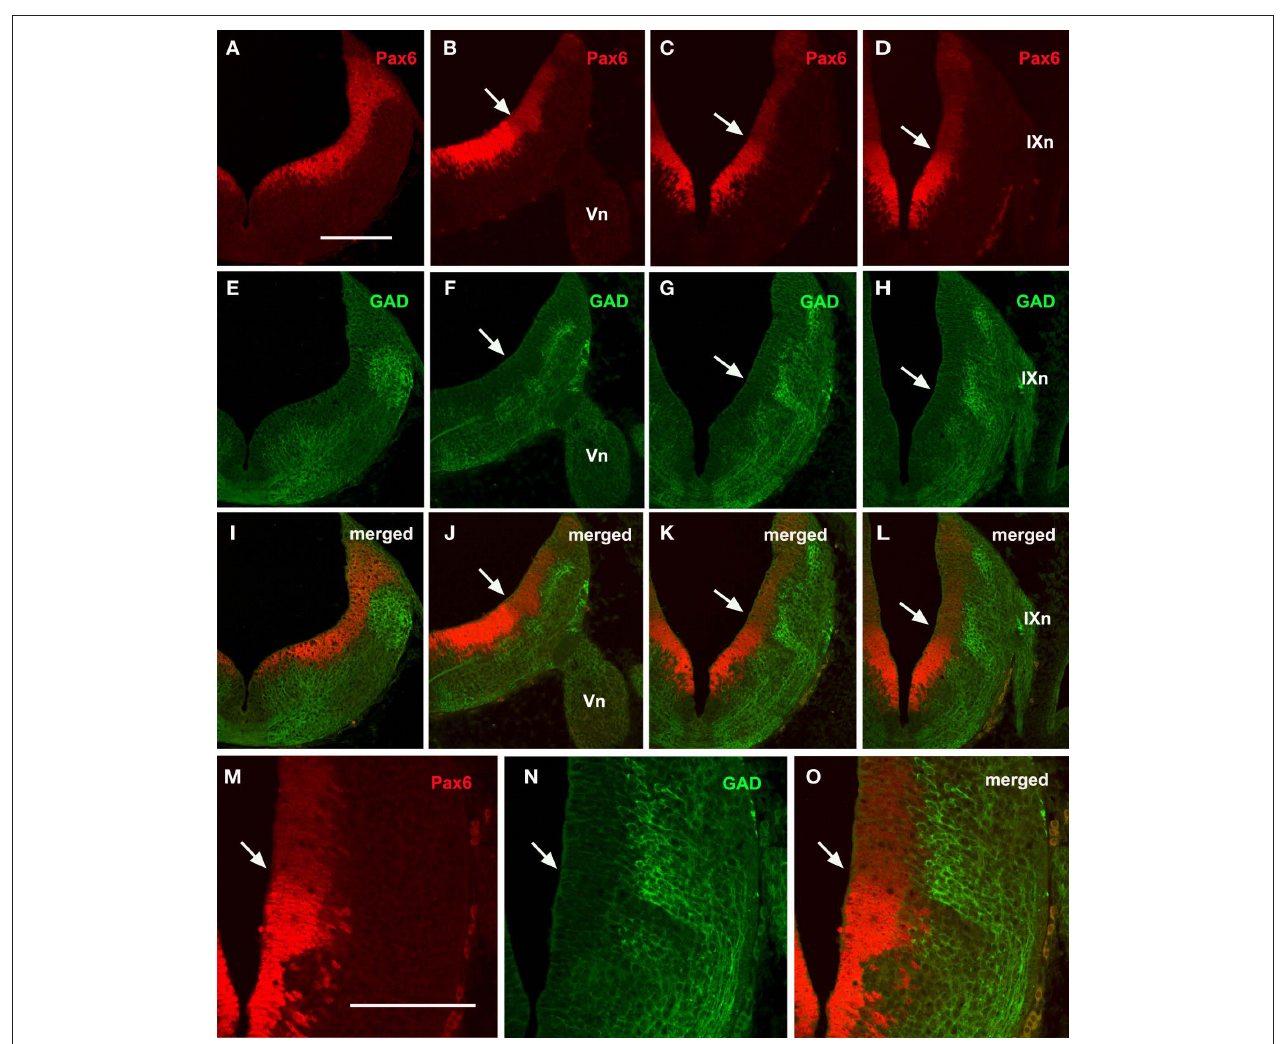
band of GAD-negative cells coinciding with the interface between intense and weak Pax6 cells that may corresponds to the alar–basal boundary